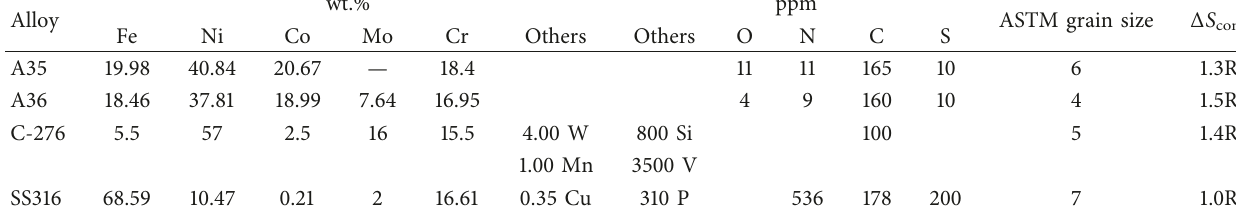
Table 1: Alloy compositions, grain size, and configurational entropy.